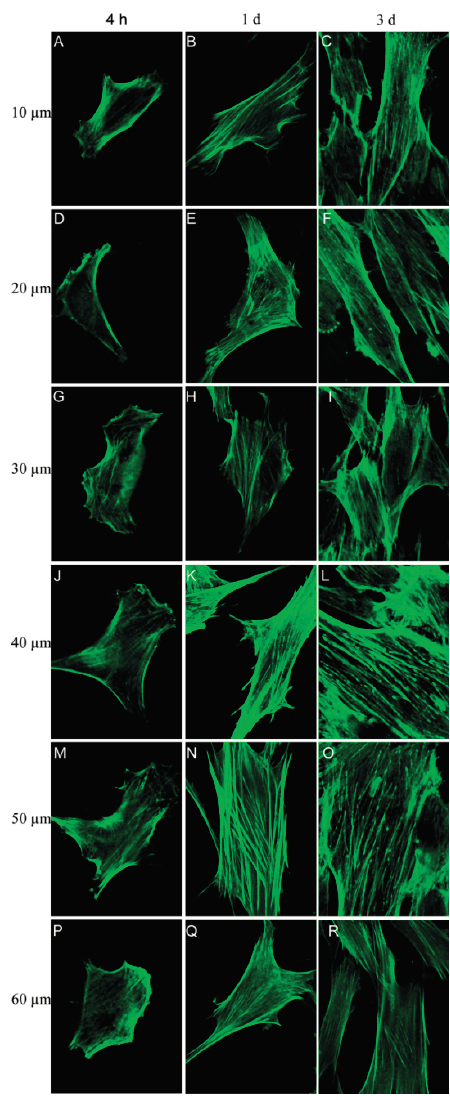
Figure 4. Fluorescence staining of the actin cytoskeleton of the fibroblasts cultured on microporous structures with different micropore diameters: ( A – C ) 10 µm; ( D – F ) 20 µm; ( G – I ) 30 µm; ( J – L ) 40 µm; ( M – O ) 50 µm; and ( P – R ) 60